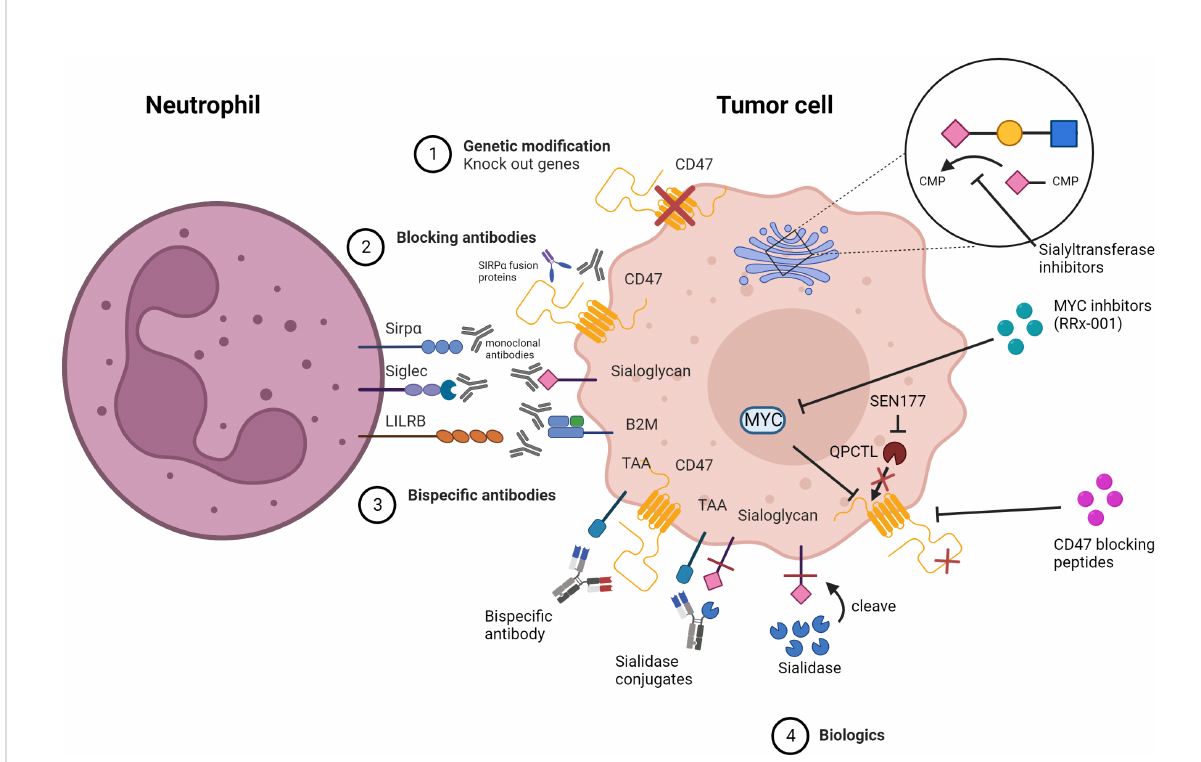
FIGURE 5 Strategies for inhibiting myeloid checkpoints. 1) Genetic knock out of target genes involved in the inhibitory pathway. 2) Speci fi c blocking of target checkpoint molecules with mAbs or soluble ligand-Fc fusion proteins to inhibit receptor binding and checkpoint axis activation. 3) Bispeci fi c antibodies that target both TAA and checkpoint molecules simultaneously to avoid off-target side effects.4) Biologics that alter the structure of the target protein, preventing it from binding to the receptor, or that inhibit expression or block the target